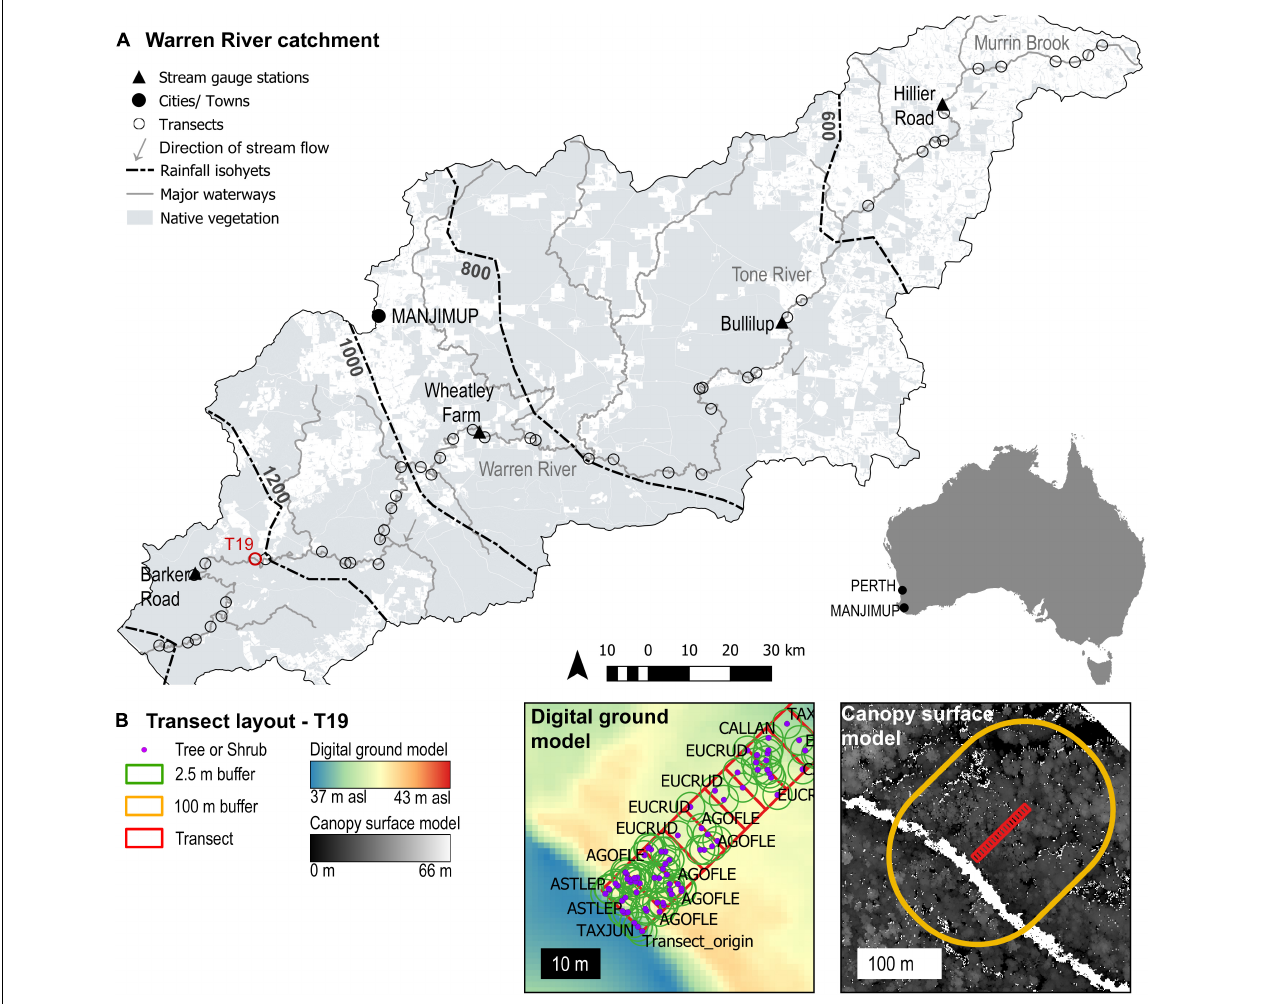
FIGURE 1 | The Warren River Catchment and vegetation survey design. (A) The Warren River Catchment in the south-west of Western Australia marking the locations of vegetation transects, the Department of Water Gauge stations (Department of Water and Environmental Regulation, 2016), and the coverage of native vegetation (DPIRD, 2020), on basemaps sourced from Geoscience Australia (2016). (B) The layout of vegetation transects, demonstrated with T19, where transects were rectified using aerial imagery, field photographs and digital elevation models. The elevation of each tree was calculated relative to transect origin. Forest structure was quantified within buffer zones of 2.5 m for individual plants, and 100 m for transects. Note that the river in the canopy surface model is white, where no vegetation points were